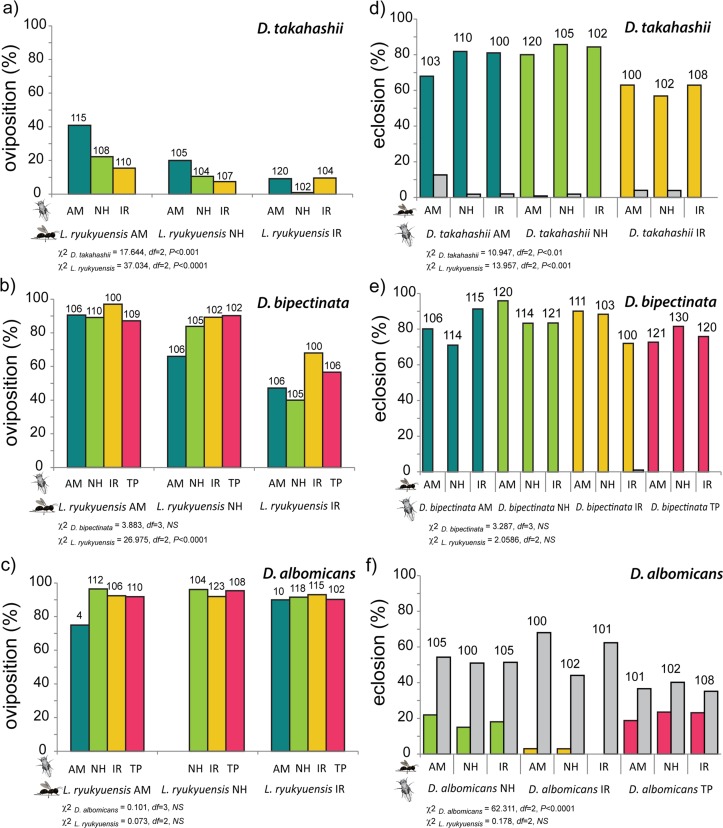
Host acceptance and host suitability.Left column shows the host acceptance of AM, NH, and IR strains of L. ryukyuensis for each strain of D. takahashii, D. bipectinata, and D. albomicans. Right column shows the emergence of flies (in colour) and wasps (gray) in host suitability experiments. Numbers above each bar indicate the number of host larvae tested. Colours represent different fly populations: AM (blue), NH (green), IR (yellow), and TP (red). Chi-squared and P values obtained for fly strains as predictor variables, and wasp strains as predictor variables, are given below each graph.